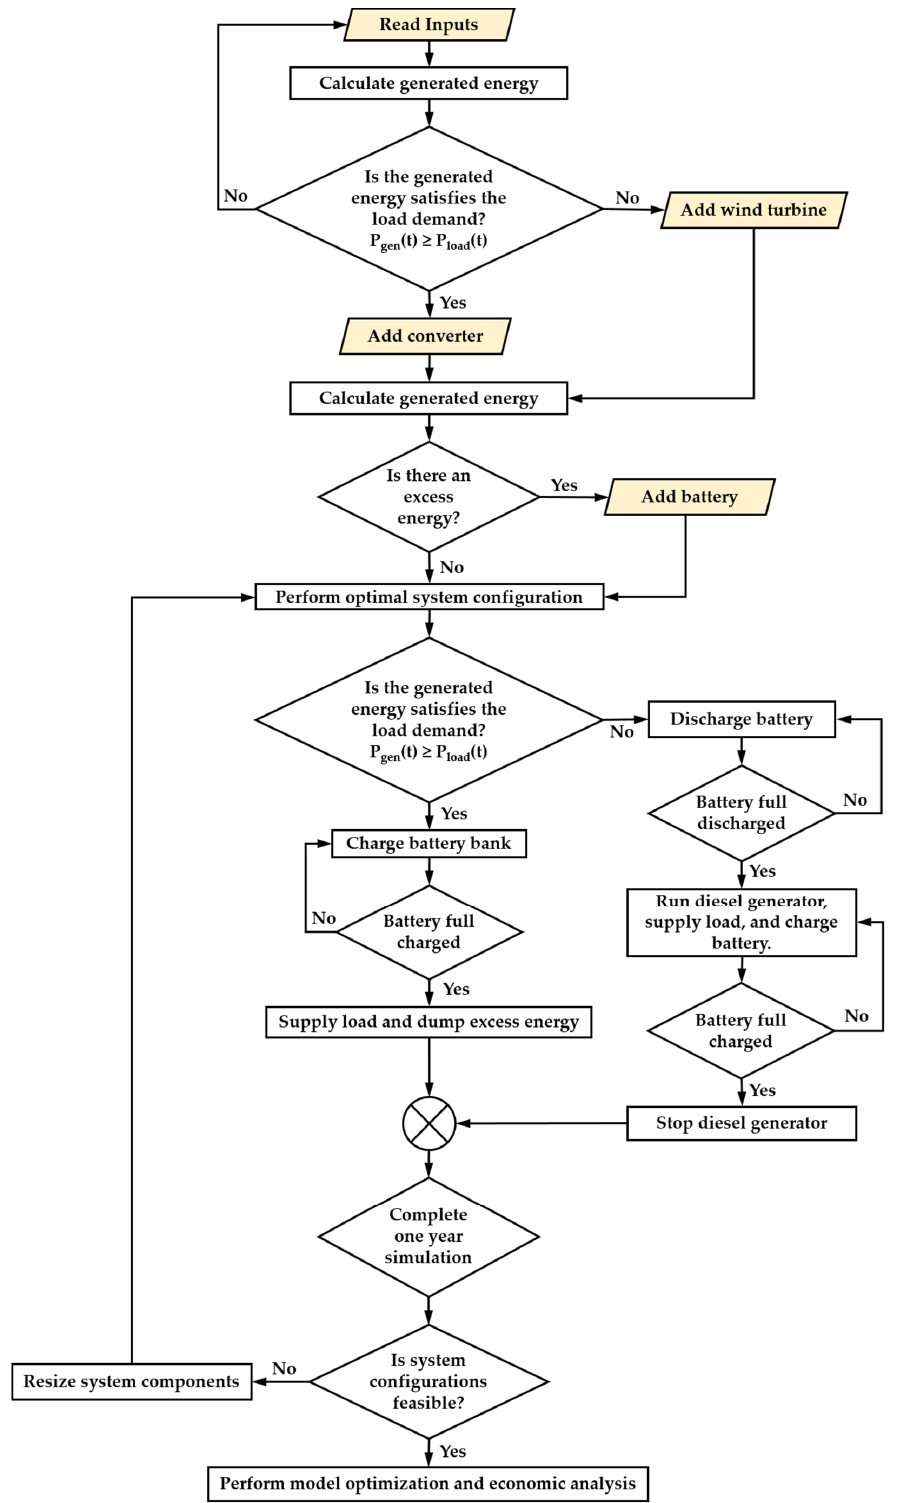
Figure 4. Flowchart for the techno-enviro-economic analysis and control strategy of Minimal Transition Scenario (MTS).